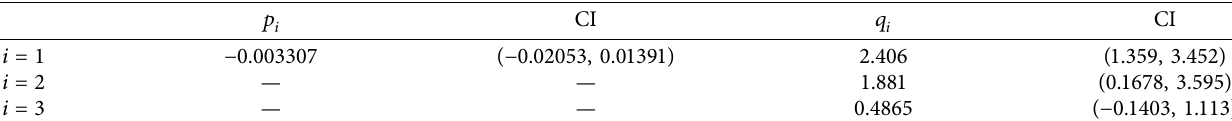
Table 14: HoF vs. Re G